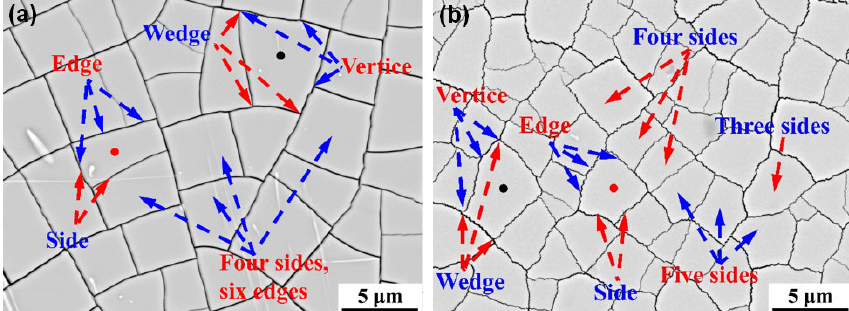
Fig. 18 Geometry and topology: (a) distinction between topology and geometry of La 0.5 Sr 0.5 CoO 3 patterns with straight crack paths and (b) La 2 Zr 2 O 7 patterns with zigzag crack paths. Reproduced with permission from Ref. [116], © ASM International 2016.